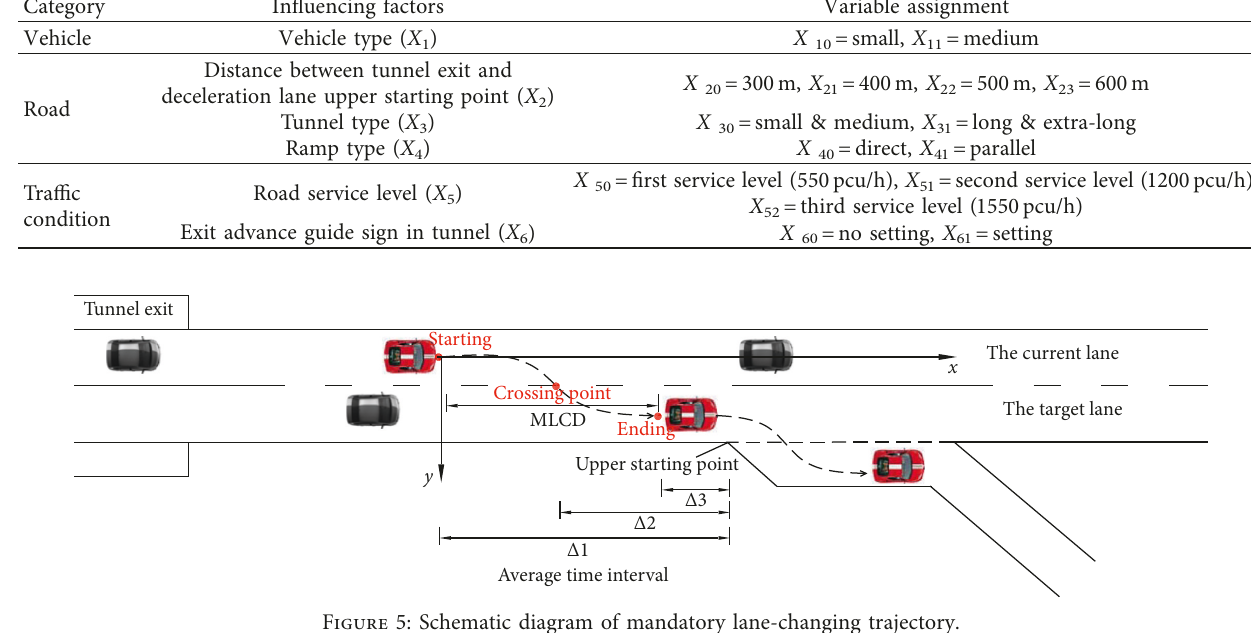
Figure 5: Schematic diagram of mandatory lane-changing trajectory.